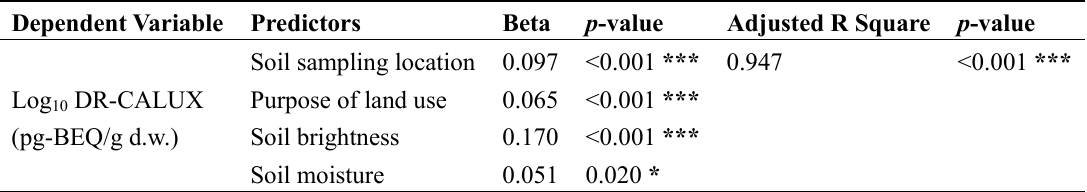
Table 3. Stepwise multiple linear regression analysis identifying the soil characteristics predicting DR-CALUX concentration